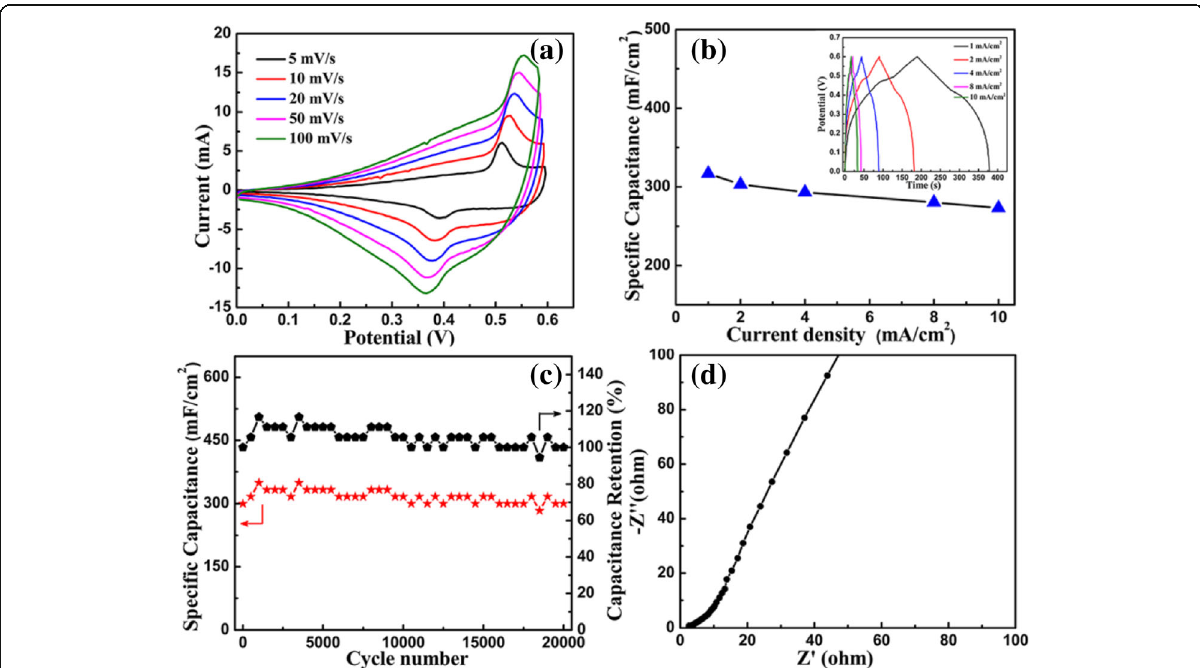
Fig. 6 Electrochemical performance of the Cu(OH) 2 /graphene composite. a CV curves. b The specific capacitance and galvanostatic charging/ discharging curves. c Area capacitance and Coulombic efficiency at a current density of 2 mA cm − 2 . d Nyquist plot of the Cu(OH) 2